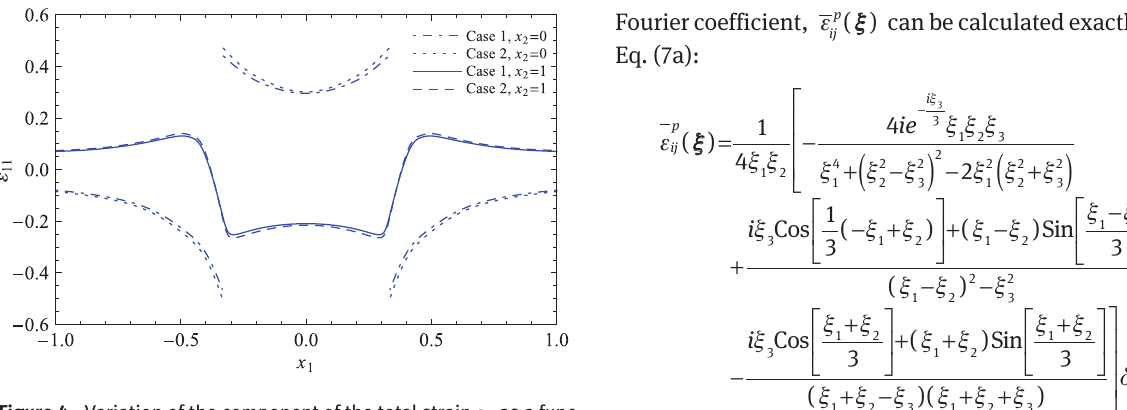
1, 0) of the zone between the